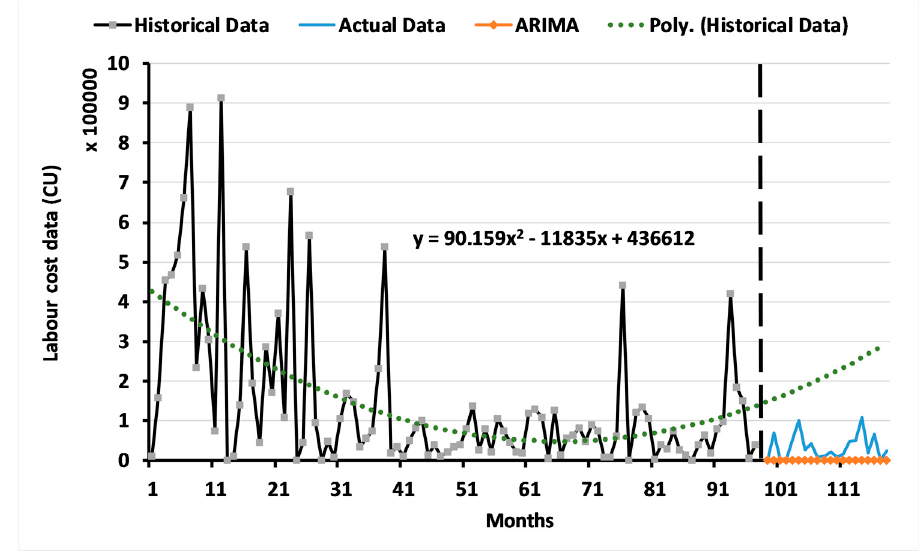
Figure 2. Labour cost data forecasting based on the ARIMA model.